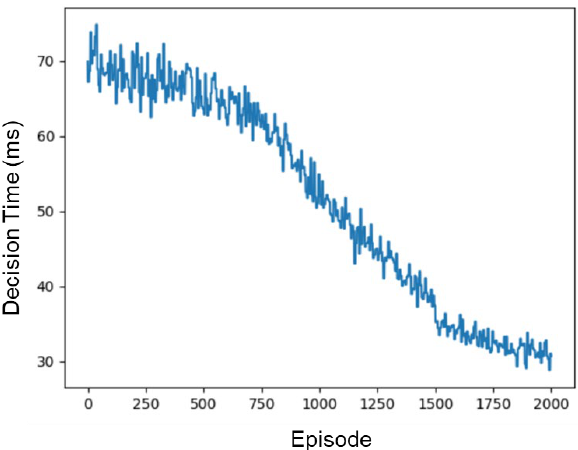
Figure 15. The average decision time change during training.